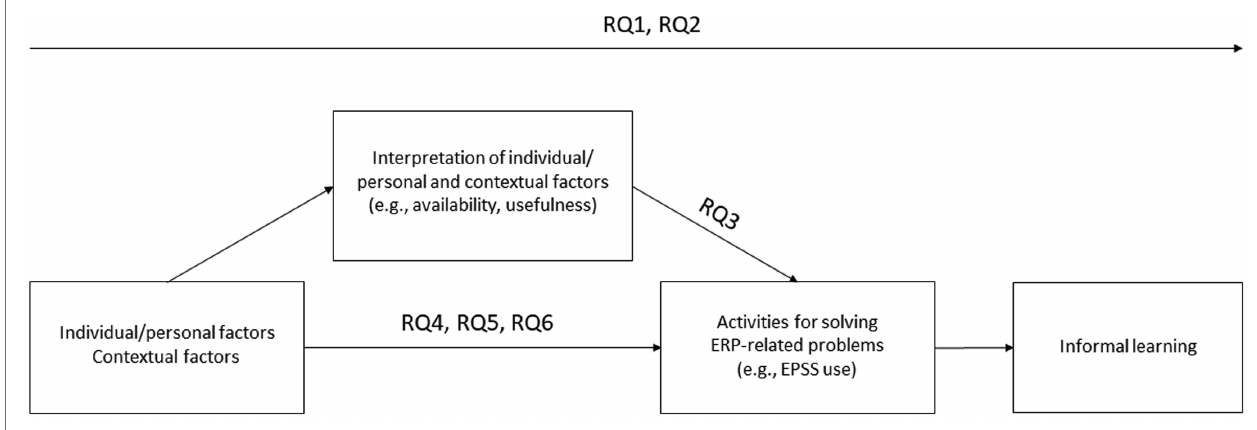
FIGURE 1 | Conceptual model of the investigated research